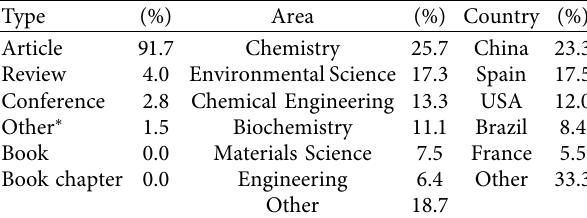
Figure 2: Number of publications related to the removal of caffeine from water using adsorption per quadrennium. Table 1: Distribution of publications by type, area, and country.